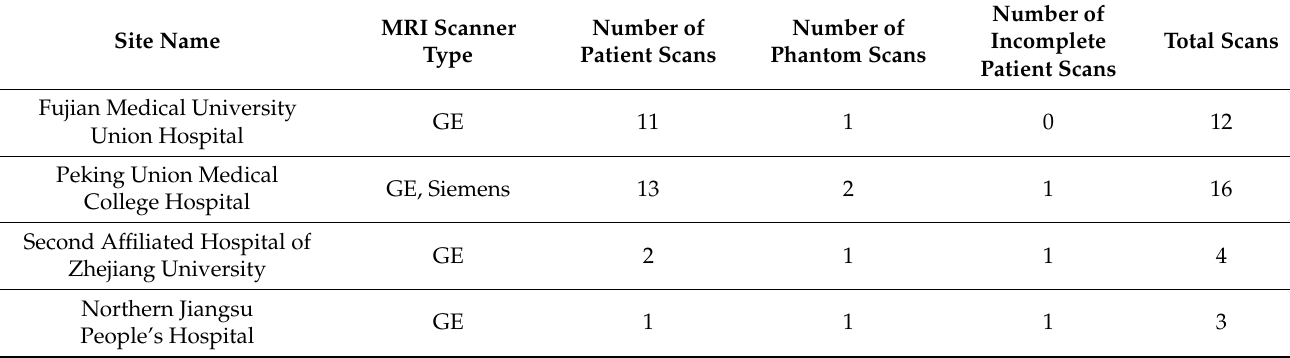
Table 2. List of VW-MR Scans at Chinese